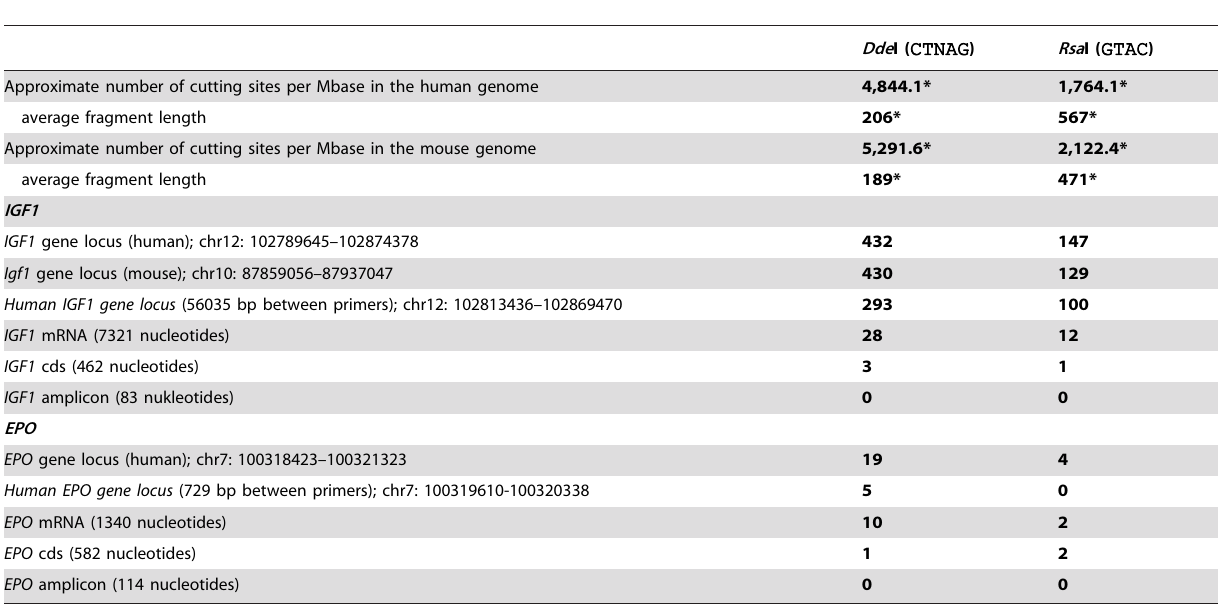
Droplet Reader (Bio-Rad) where flow cytometric analysis deter- mined the fraction of PCR-positive droplets vs. the number of PCR-negative droplets in the original sample. Data were analysed using Poisson statistics to determine the target DNA template concentration in the original sample. Optimal annealing temper- Table 2. Number of restriction sites for Dde I and Rsa I in the human/mouse genome and at the IGF1 and EPO gene locus.